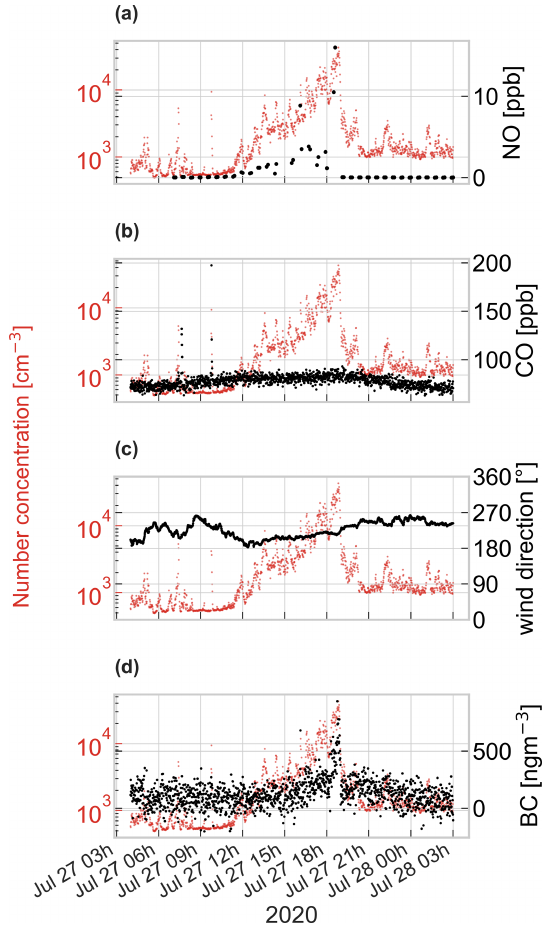
Figure A4. Particle number concentration (left axis) along with (a) NO (in parts per billion; ppb), (b) CO (ppb), (c) relative wind direction, and (d) equivalent BC (ngm − 3 ) at 880nm with standard manufacturer settings for the correction factor and mass absorption cross section during a local contamination event in the afternoon of 27 July 2020. Starting around 12:00, the particle number concentration and NO and BC concentrations increased as wind came from the stack. Note that CO concentrations did not exhibit any significant variability during that event.